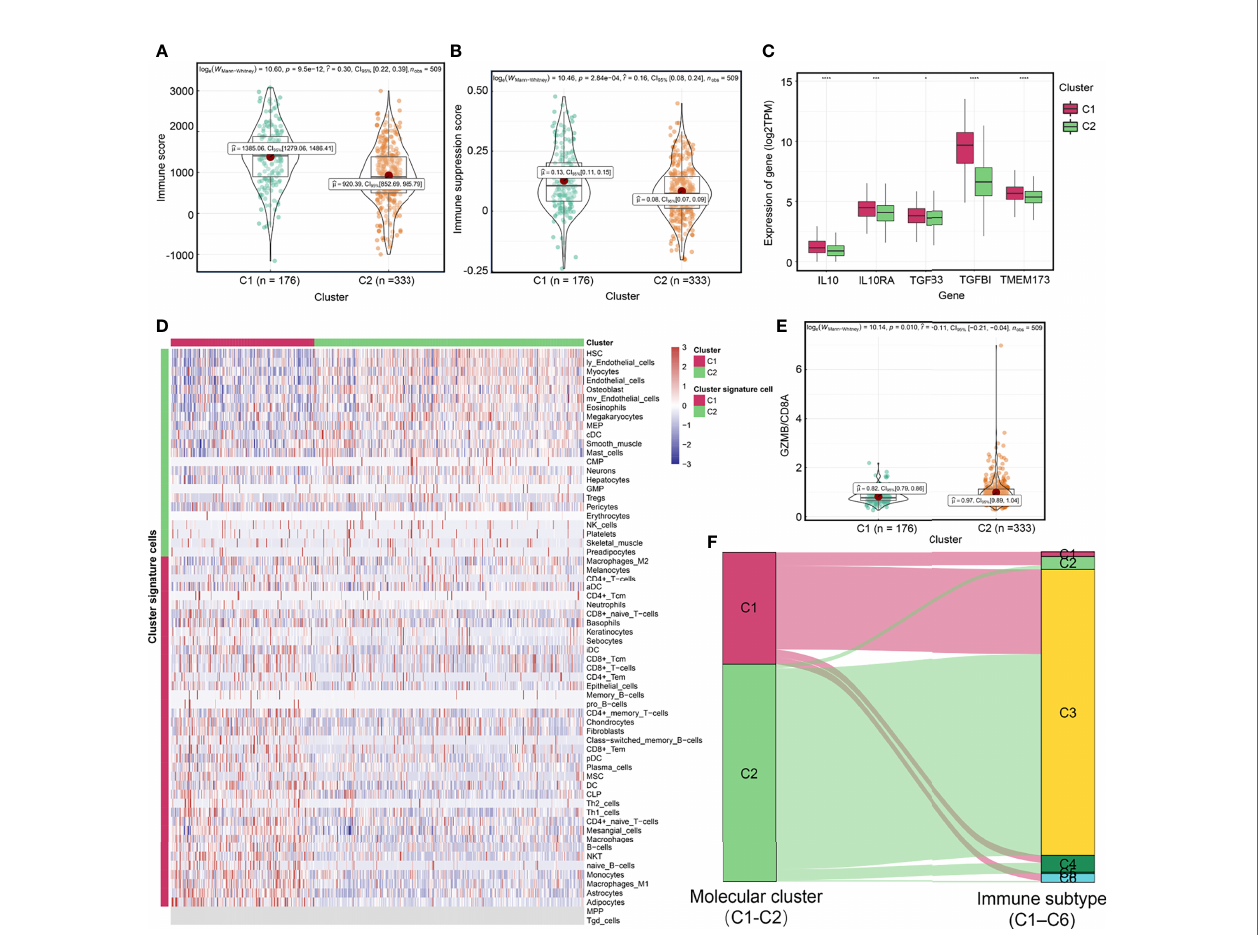
FIGURE 4 | Exploration of extrinsic immune escape mechanisms among molecular clusters. Differences of immune score (A) and immune suppression score (B) between two molecular clusters. (C) Differences of the expression of TMEM173 (STING), IL10, IL10RA, TGFB3 and TGFBI between molecular clusters. (D) The relationship between molecular clusters and immune and non-immune cells in the tumor microenvironment. (E) The GZMB/CD8A ratio among molecular clusters. (F) A Sankey plot was used to reveal the correlation between molecular cluster and immune subtype. (**** P < 0.0001; *** P < 0.001; * P <